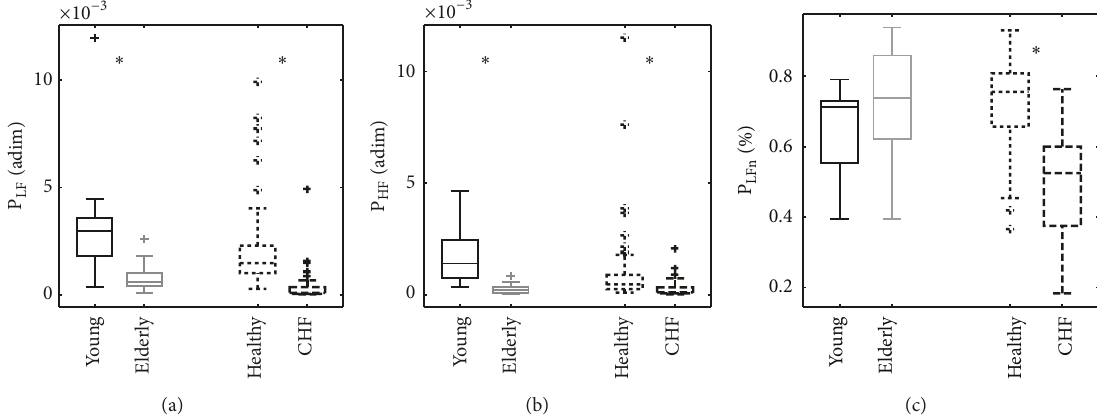
; (b) P ; and (c) P computed comparing young and elderly, and CHF patients and healthy LF HF LFn